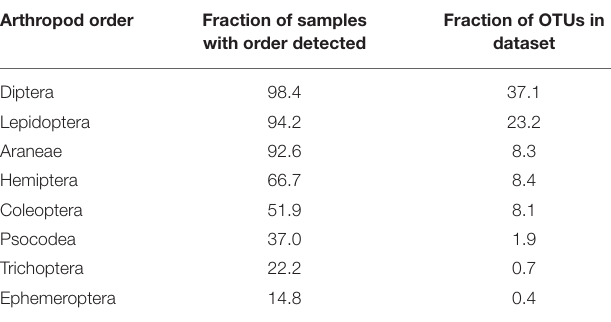
TABLE 1 | Eight arthropod orders detected in at least 10% of